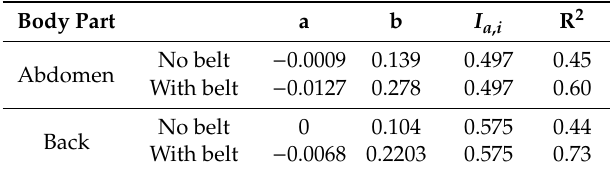
Table 5. Coe ffi cients of regression equations for the abdomen and back. Body